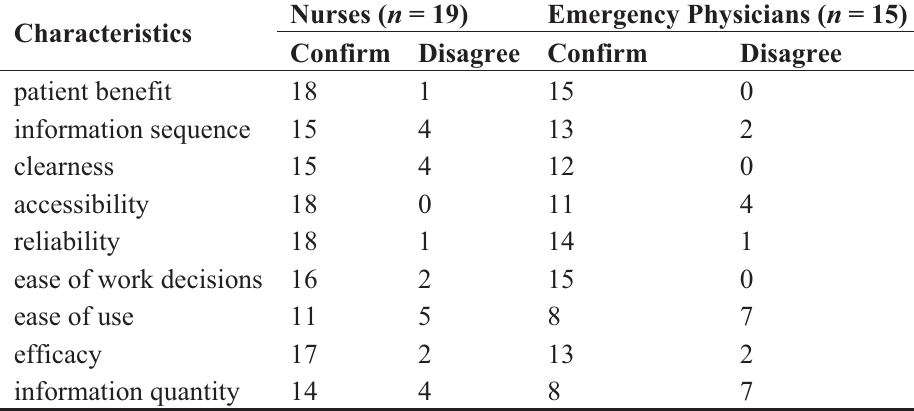
Table 1. Satisfaction with palliative treatment plan (PTP) regarding patient benefit, information sequence, clearness, accessibility, reliability, ease of work decisions, ease of use, efficacy and information quantity as reported by nurses and emergency physicians (Confirm is 1 and 2; disagree is 3, 4 and 5 on the Likert